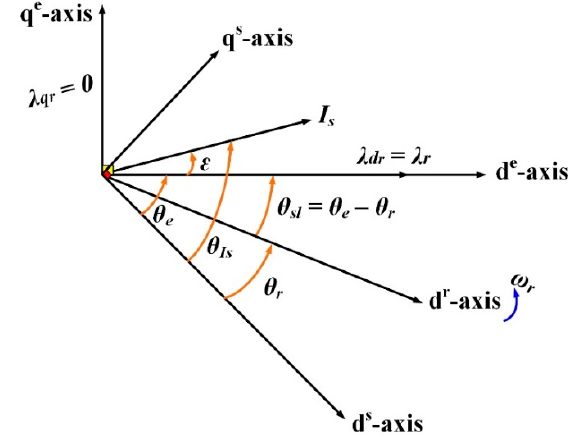
Figure 3. IM phase-axis relations in the case of IRFOC technique.